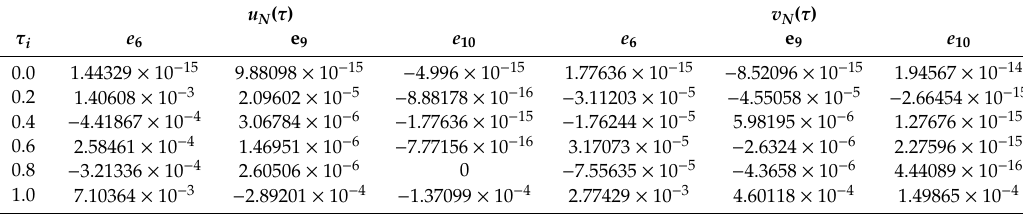
Table 12. Comparison of the errors of the present of di ff erent values for N .